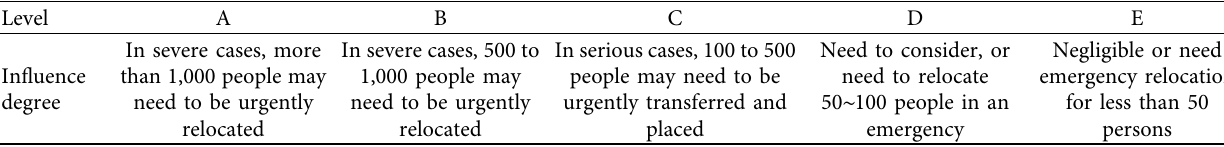
Table 8: Social impact rating criteria.